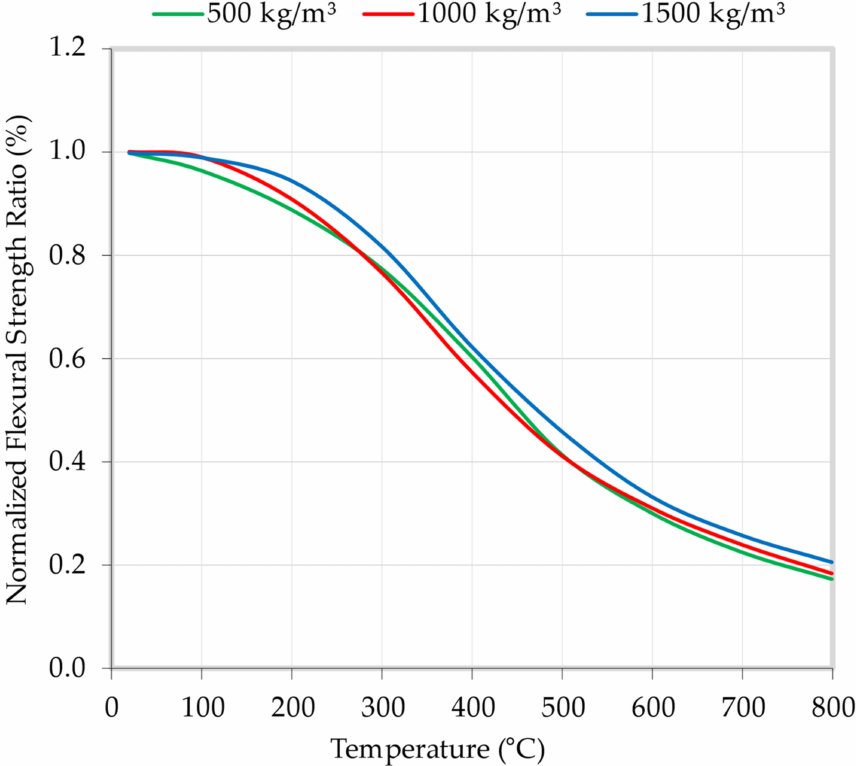
Figure 16. Influence of varying temperatures on the normalized LFC flexural